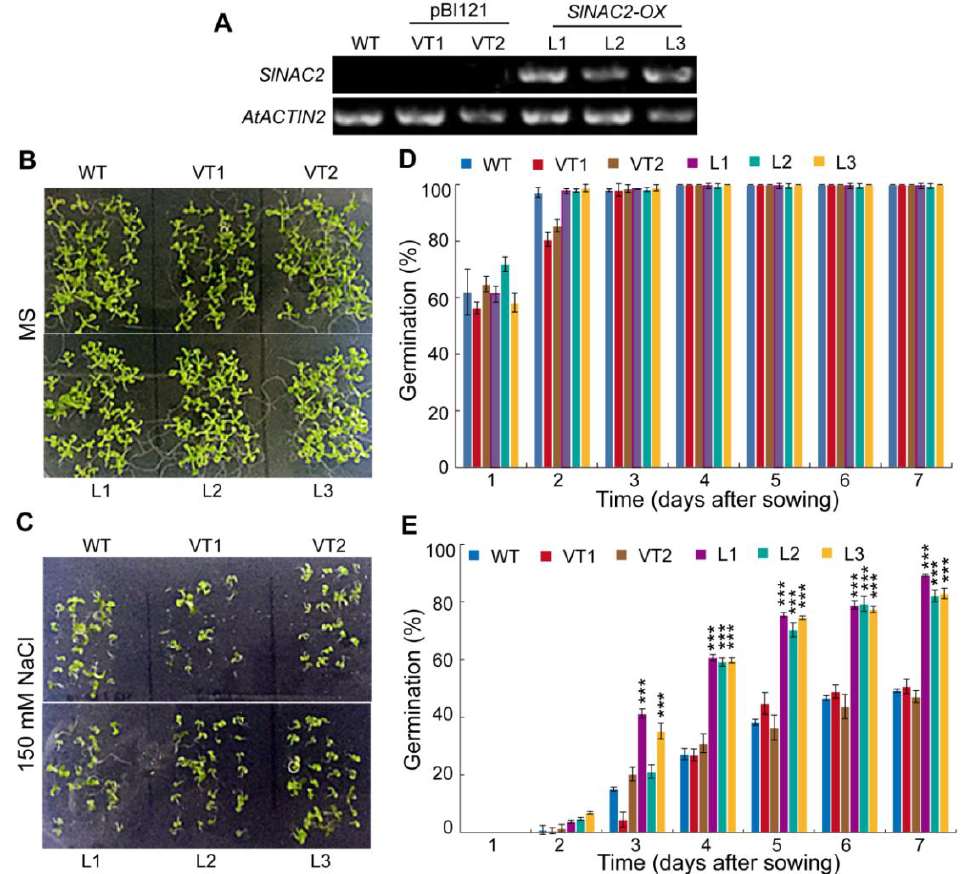
Figure 8. Functional characterization of Sl NAC2 in seed germination under salinity stress in Ara- bidopsis . ( A ) RT-PCR analysis of the SlNAC2 expression level from wild-type (Col-0), pBI121 plants (VT1 and VT2), and SlNAC2 transgenic plants ( SlNAC2-OX ) in Arabidopsis . AtACTIN2 as the internal control. ( B , C ) Phenotypes of seed germination at 7 DAS from wild-type (Col-0), pBI121 plants (VT1 and VT2), and SlNAC2-OX plants in MS medium with or without 150 mM NaCl treatment. ( D , E ) Germination rates were calculated from wild-type (Col-0), pBI121 plants (VT1 and VT2), and SlNAC2-OX plants in MS medium with or without 150 mM NaCl treatment. Germinated seeds were scored daily, and radicle protrusion was used as the morphological marker. Values presented are the means ± SD for three independent experiments ( n = 60 seeds for each line). Significant differences were analyzed using one-way ANOVA followed by LSD test (*** p < 0.001). OX ,